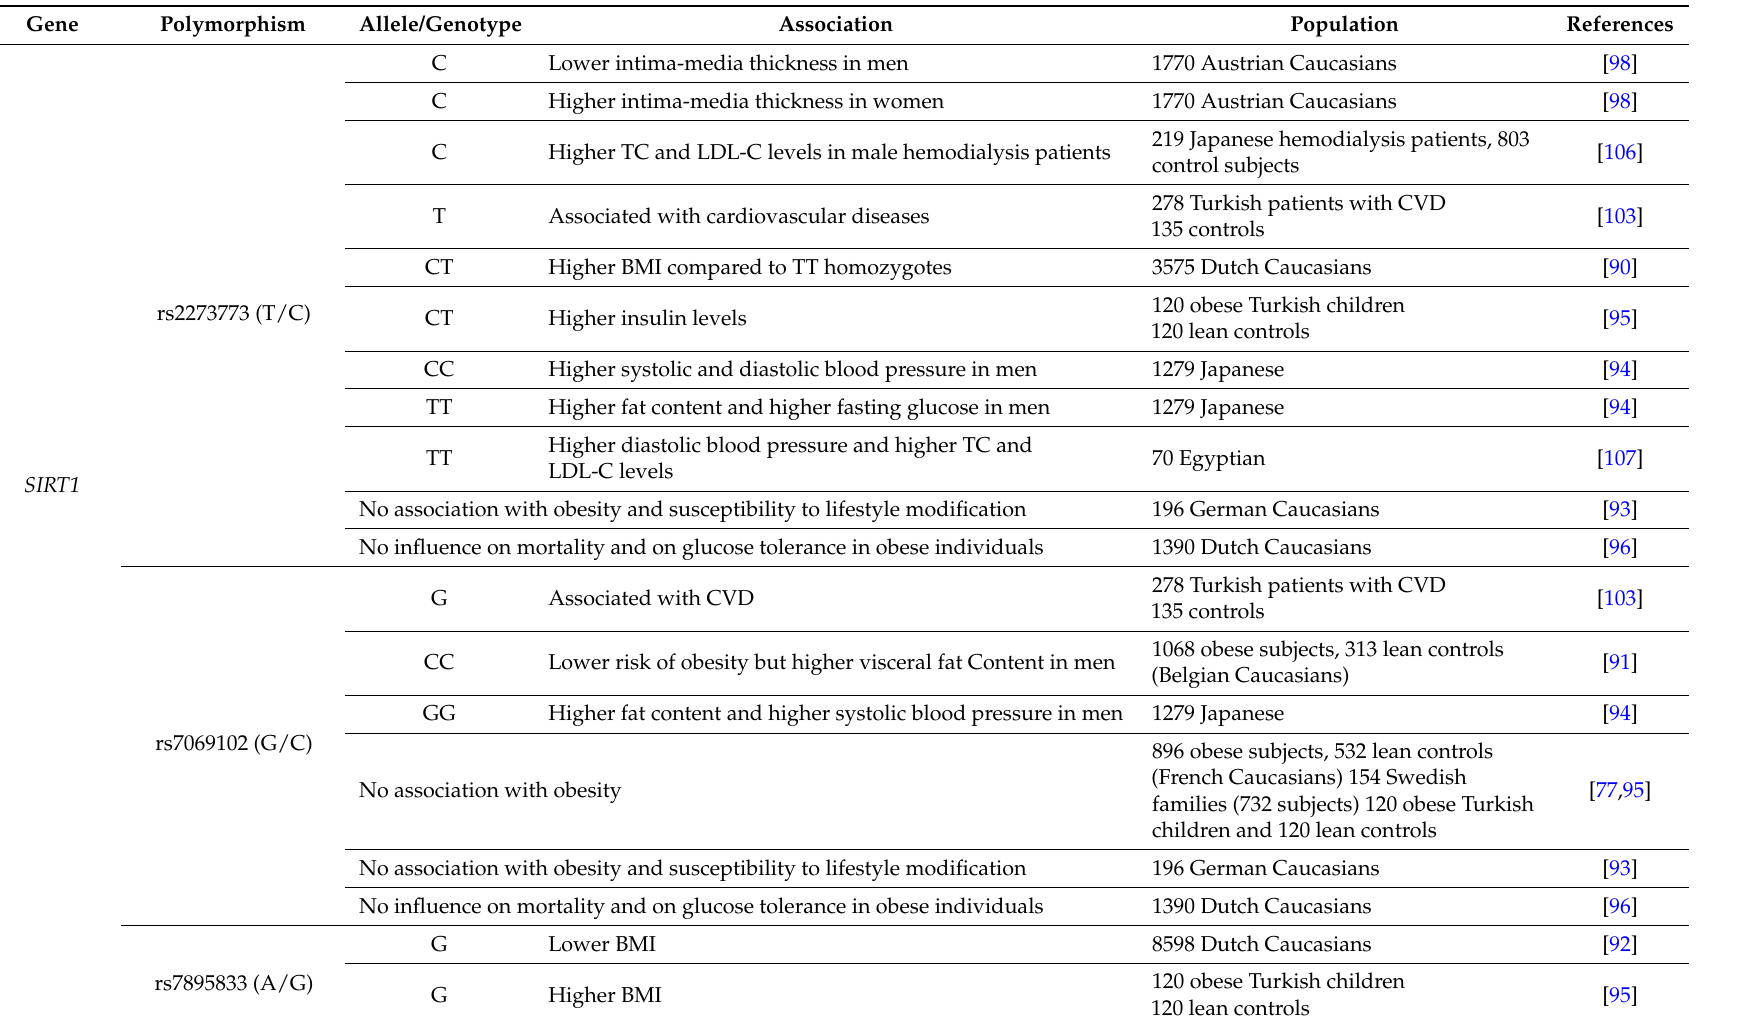
Table 1. Associations of single nucleotide polymorphisms in genes encoding sirtuins ( SIRTs ) with obesity and related